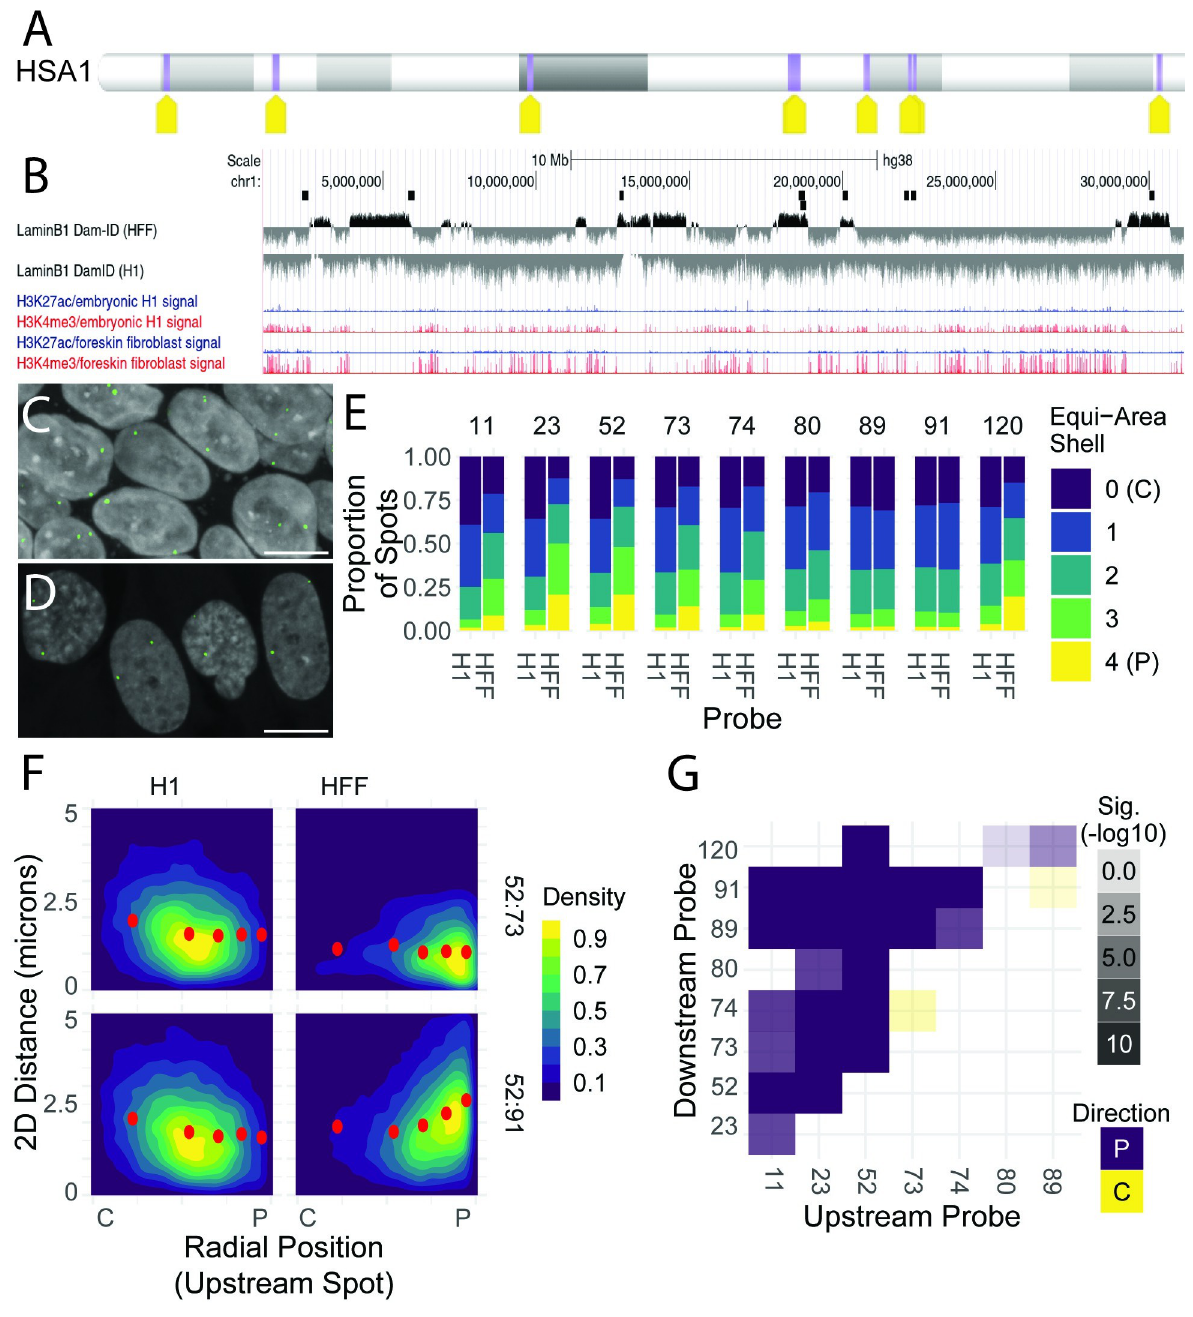
Fig 3. Embryonic stem cells show centralization of probes but peripheral trend for interactions. A: Schematic location of all probes tested in H1 embryonic cells on chromosome 1. Yellow tags: probes stained in H1 cells; purple bars: all probes stained in HFF cells. B: UCSC Genome Browser track showing LAD position and chromatin type for a region on the P arm of chromosome 1 in H1 hESCs (embryonic H1) and HFFs (foreskin fibroblast). C: Representative field of H1 human embryonic stem cells: DAPI staining (gray) and FISH (green). Scale bar: 10 μ m. D: Representative field of HFFs: DAPI staining (gray) and FISH (green). Scale bar: 10 μ m. E: Bar charts showing general centralization of all probes in this region in H1 cells relative to their position in HFF cells. F: 2D density plots showing radial position of one locus (locus 52) as a function of 2D spatial distance to a downstream locus (locus 73 or 91 as noted) in both HFFs and H1 hESCs. Correlation coefficients and number of spot pairs per locus pair is in S2 Table. G: Heatmap showing correlation between radial position of upstream probe and pairwise spatial distance between two probes in H1 cells.